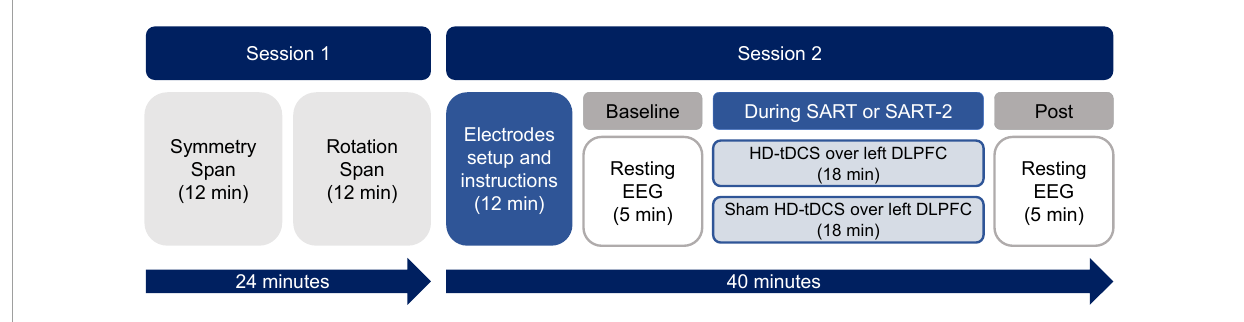
FIGURE1 Schematic illustration of the experimental procedure.